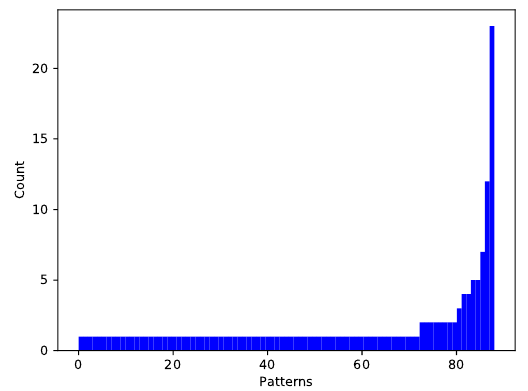
Figure 9. Frequency of the behavior patterns of a static object (lantern).